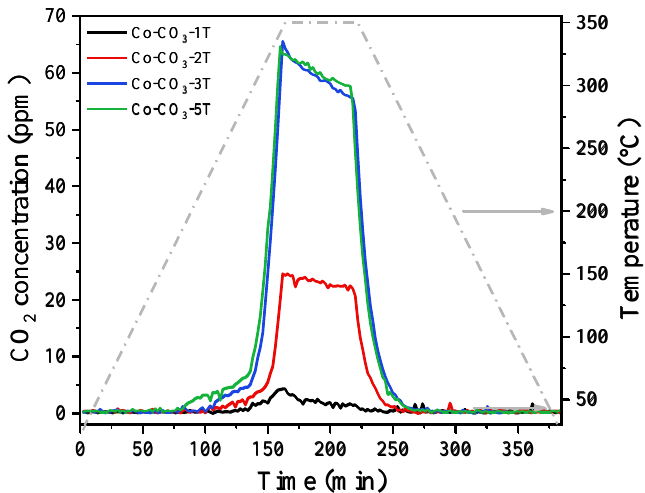
Figure 9. Evolution of CO 2 concentration in propane oxidation without oxygen over the catalysts.